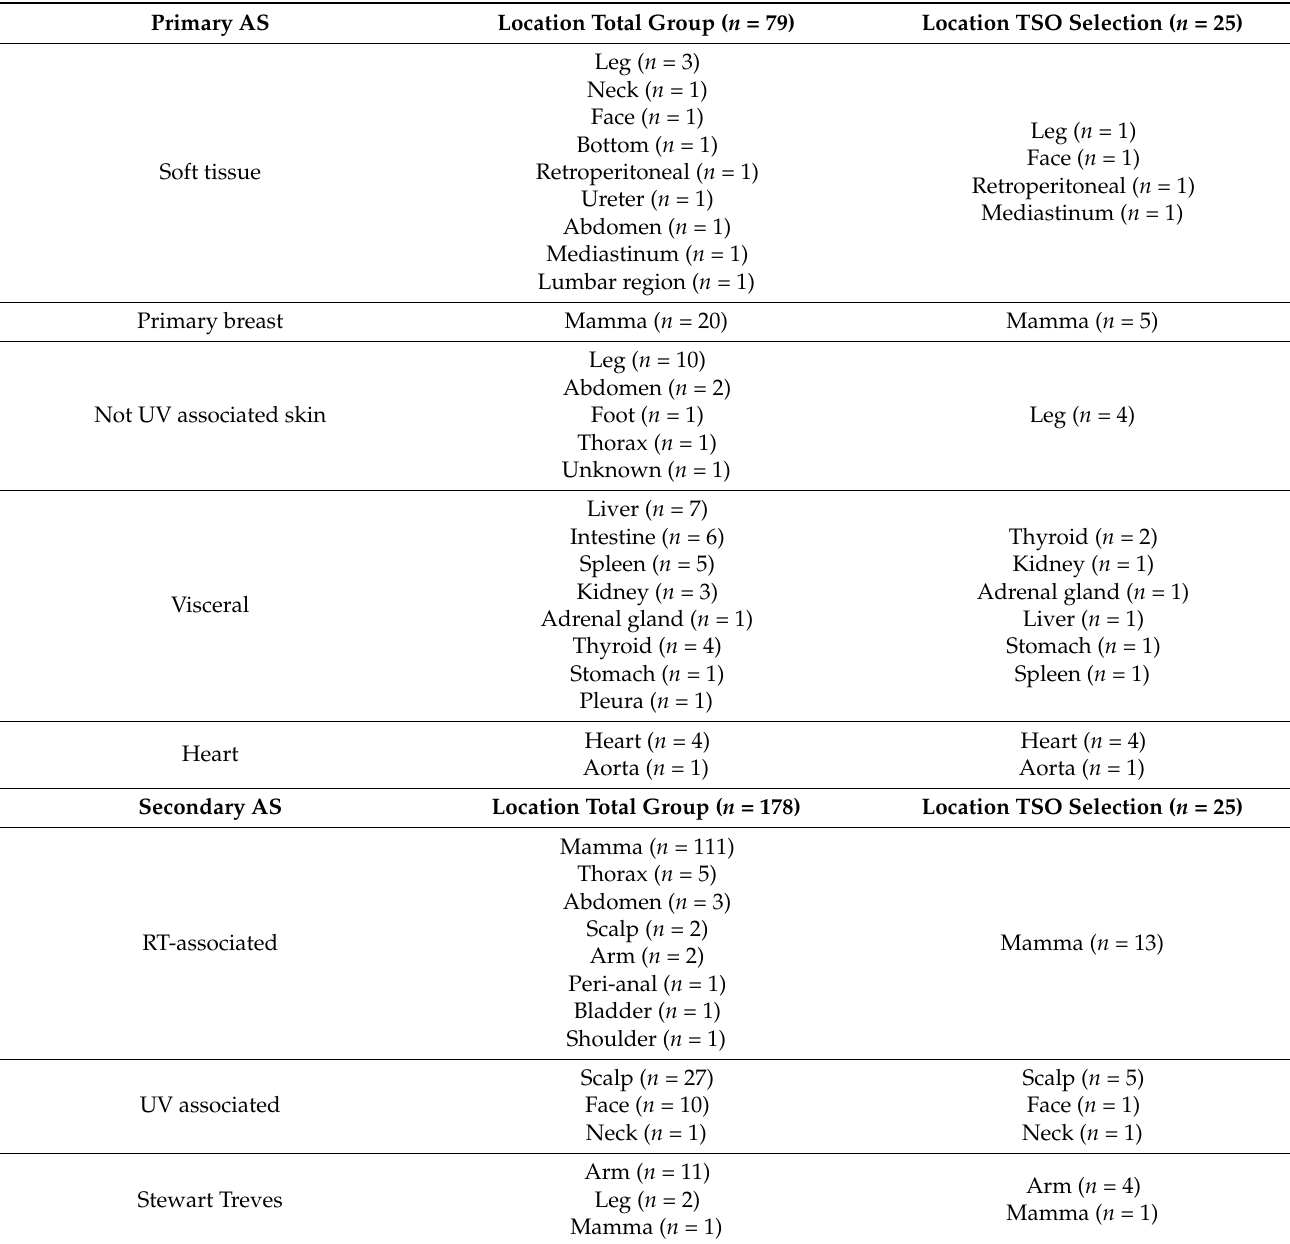
Table 1. Tumor location for the specific AS subgroups for both primary and secondary